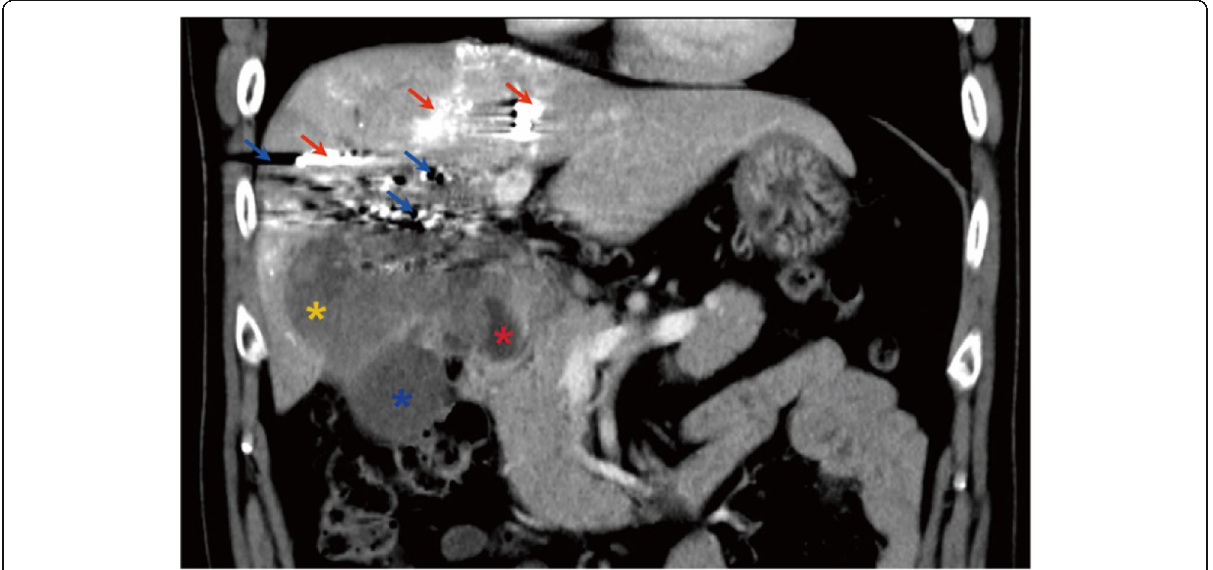
Fig. 1 CT scan showing the mass located in the gallbladder, liver, and duodenum. The blue asterisk represents the non-tumor fundus of the gallbladder. The yellow asterisk represents the liver parenchyma infiltrated by the tumor. The red asterisk represents the tumor protruding into the duodenal lumen. The red arrows represents iodipin on CT images. The blue arrows represents CT